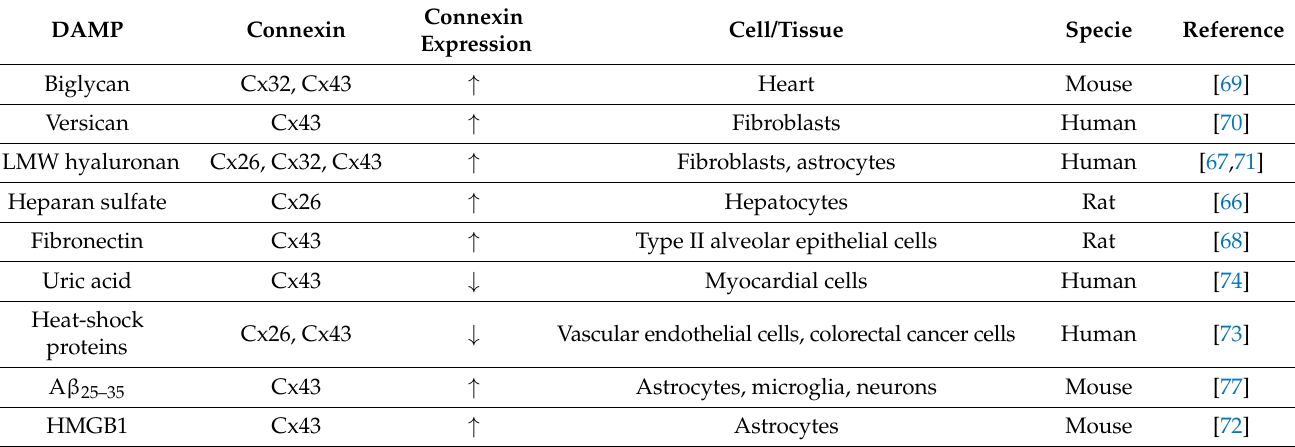
Table 1. Effects of DAMPs on connexin expression.